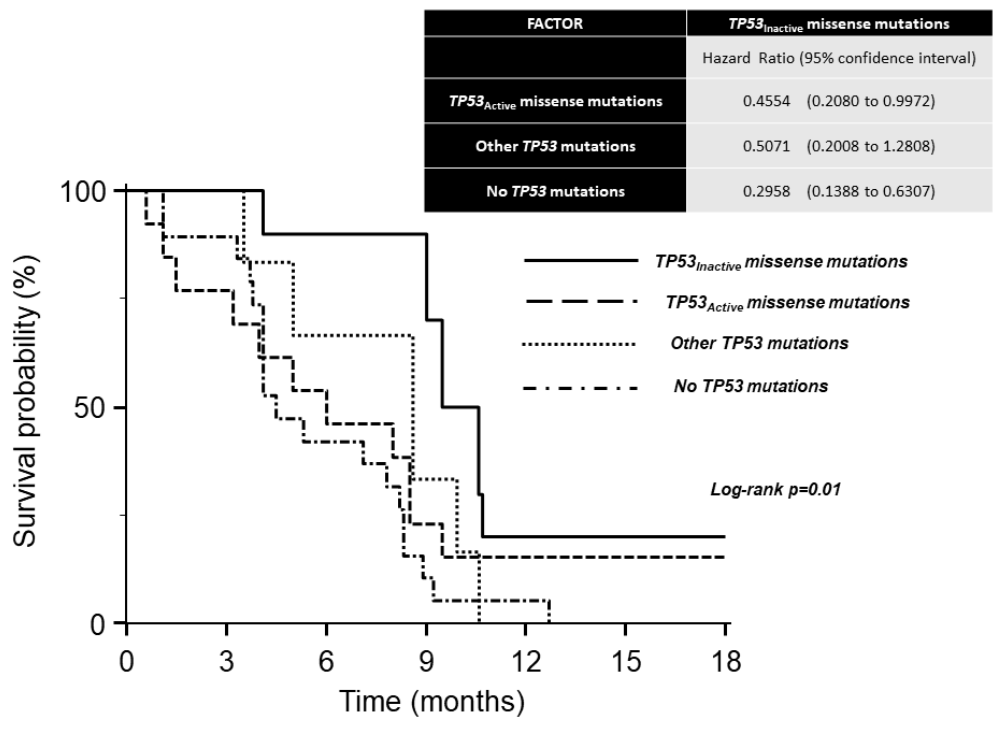
Figure 2. Results of the multivariate model analysis for overall survival in the Ramucirumab/Paclitaxel ( A ) and Standard Chemotherapy ( B ) treatment groups. Abbreviations: HR, Hazard Ratio; CI, confidence interval; ECOG PS, Eastern Cooperative Group Performance Status; PFS, progression-free survival. First PFS time* is a variable for second-line Ramucirumab/Paclitaxel therapy only. 2.4. Standard First-Line Chemotherapy and TP53 Analysis